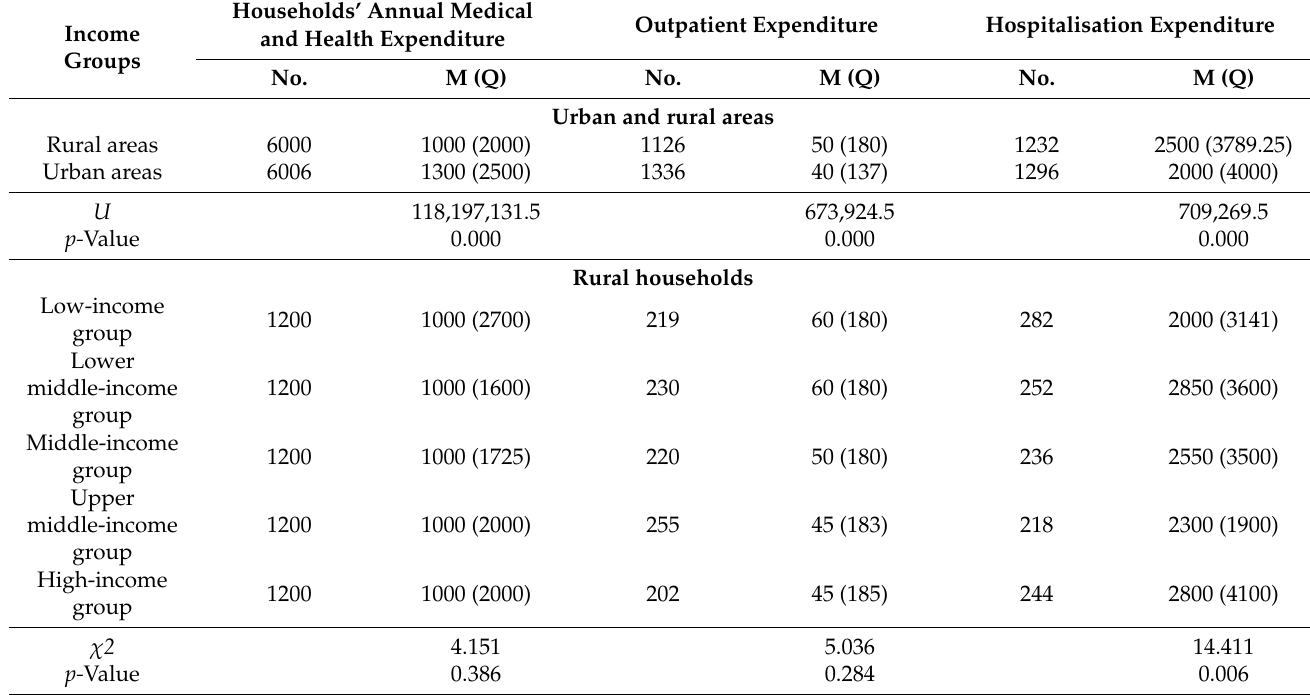
Table 3. Comparisons of health expenditure among rural and urban residents with different income groups (Median, M; Quartile Range, Q; Unit: